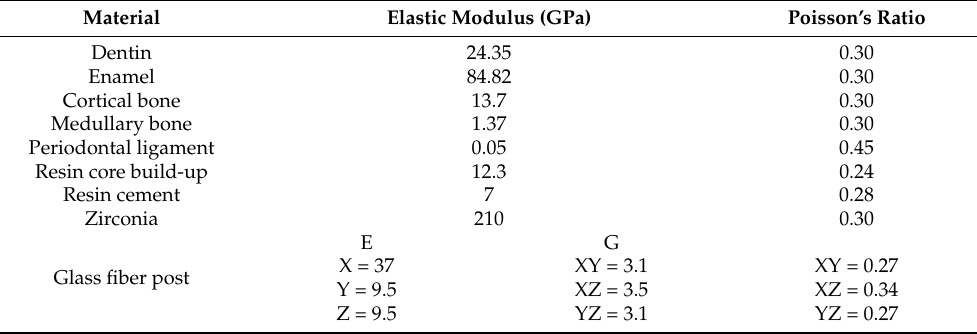
Table 1. Material’s mechanical properties: Young’s modulus and Poisson ratio. Glass fiber post was simulated with orthotropic